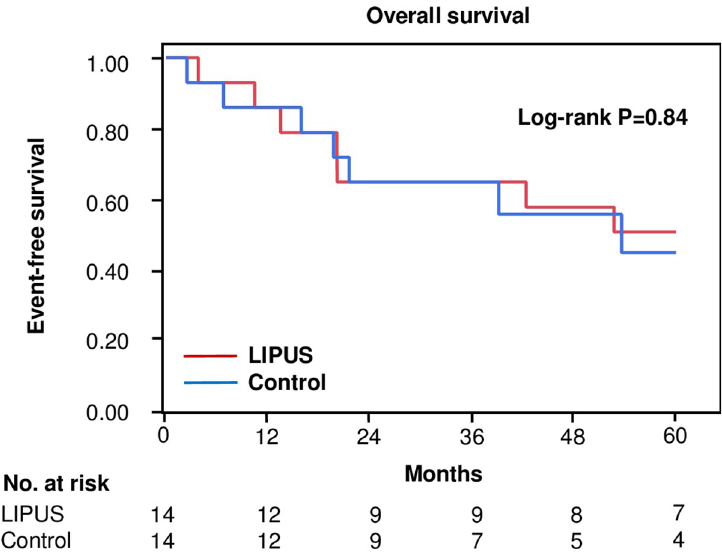
Fig 3. Kaplan-Meier analysis of overall survival rates in patients with CLI who were treated with LIPUS and in historical